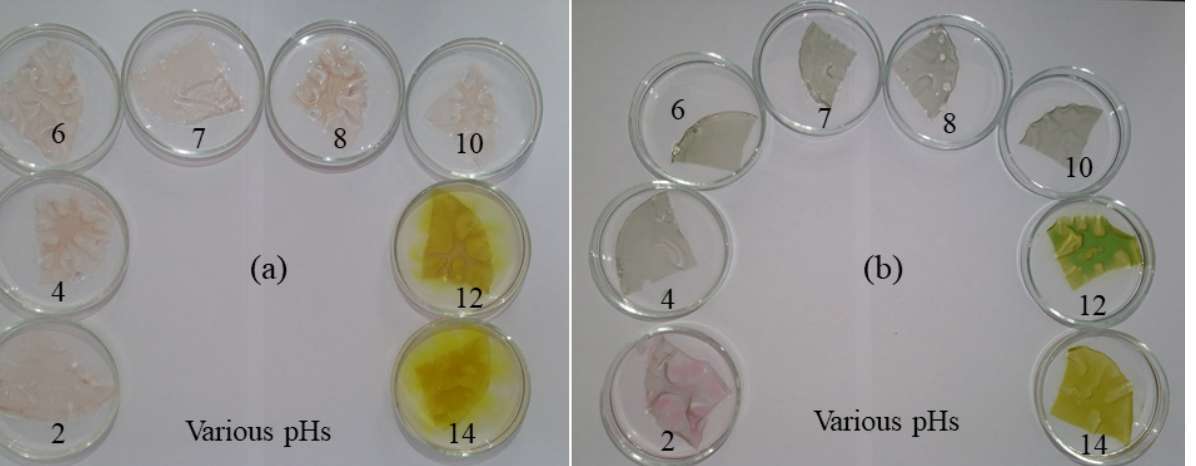
Figure 1. Absorbance spectrum of ( a ) gelatin, ( b ) gelatin/chitosan nanofibers, ( c ) G/CsNFs/Bas, and ( d ) G/CsNFs/SPAs films.